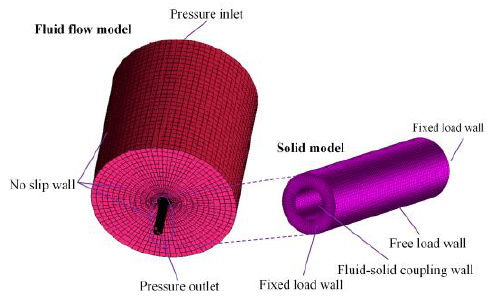
Figure 1. Fluid-solid coupling numerical model. Figure 1. Fluid – solid coupling numerical model.